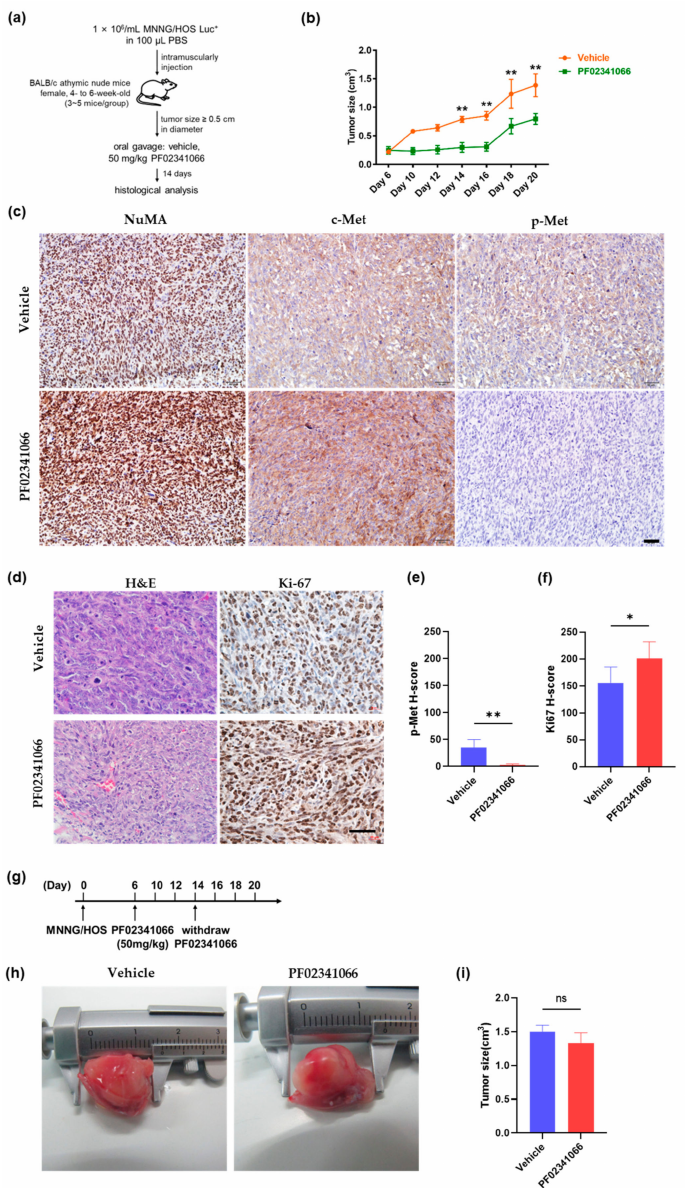
Figure 3. PF02341066 treatment of tumor-bearing mice in vivo. ( a ) Timeline for the in vivo animal experiment. Treatment started on day 6 when the tumors reached about 0.5 cm in largest diameter after tumor inoculation. Mice then received oral gavage of PF02341066 (50 mg/kg) for the next 2 weeks. ( b ) Quantification analysis on the volume of tumors. Mean ± SD, n = 5. ** p < 0.01 by two-tailed Student’s t -test. ( c ) The staining on c-Met and p-Met of tumor tissues from mice on day 20 after treatment. NuMA staining indicated human-derived MNNG/HOS cells. CD31 staining indicated tumor vessels. Scale bar = 50 µ m. ( d ) H&E and Ki67 staining of tumor tissues from mice on day 20 after treatment. Ki67, a proliferating marker staining the nucleus. Scale bar = 50 µ m. ( e , f ) Quantitative analysis on the expression of p-Met and Ki67. Mean ± SEM, five independent samples, each with n = 5. ** p < 0.01, * p < 0.05, ns p > 0.05 by two-tailed Student’s t -test. ( g ) Timeline for the drug withdrawal experiment. Treatment was withdrawn from day 14 according to the relapse timepoint. ( h , i ) Representative images ( h ) and statistical analysis ( i ) of tumors from mice on day 20 after withdrawing PF02341066. Mean ± SD, n = 5. ns p > 0.05 by two-tailed Student’s t